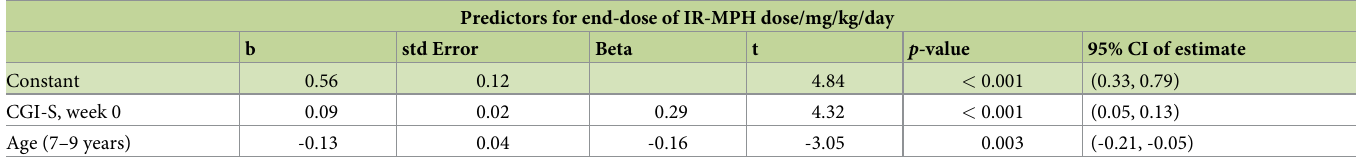
Table 5. Baseline characteristics as predictors for end-dose of IR-MPH ( n =